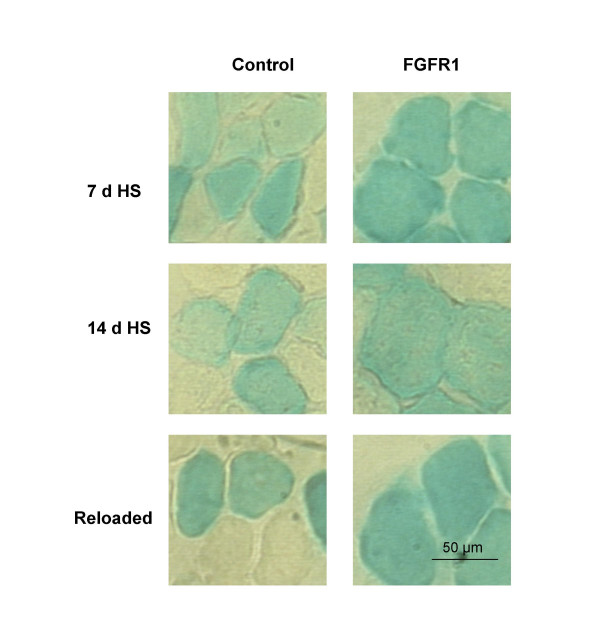
Ectopic expression of FGFR1 inhibits atrophy. β-galactosidase expression in muscle fibers from gastrocnemius muscles of mice co-transfected with a β-galactosidase expression vector and either a control (control) or FGFR1 expression plasmid DNA (FGFR1). Rows represent fibers from muscles of mice suspended for 7 d (7 d HS), 14 d (14 d HS), or reloaded for 7 d after 7 d HS (reloaded). The bar in the bottom right figure represents 50 μm.